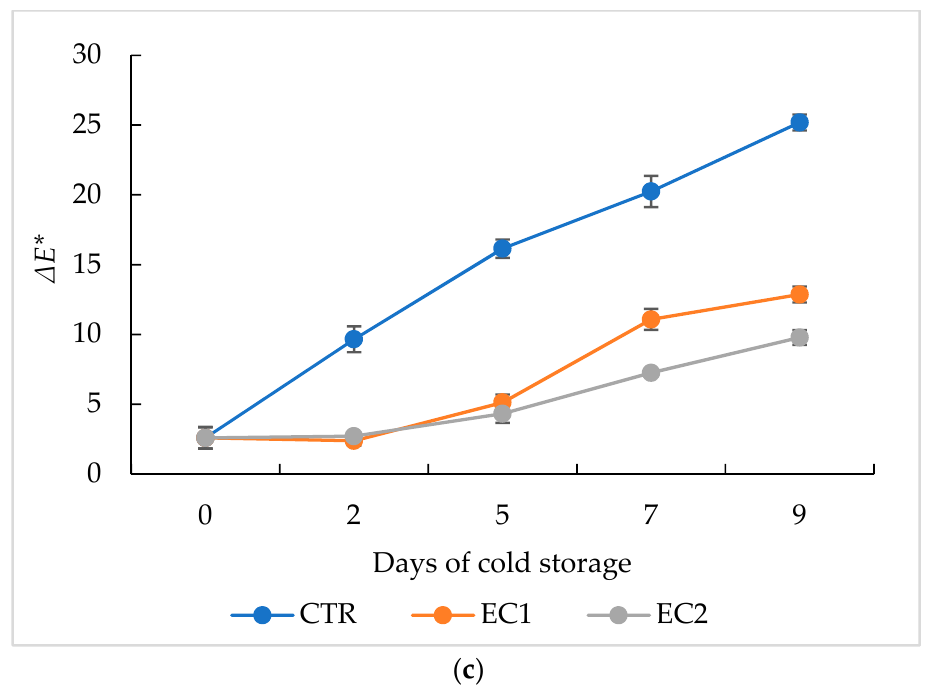
Figure 3. ( a – c ) Variation in brightness ( a – L* ), browning index ( b – BI ) and total colour differences ( c – ∆ E* ) measured during 9 days of cold storage. Data correspond to the mean and bars indicate the standard deviation (SD) of three replicates (n = 3).